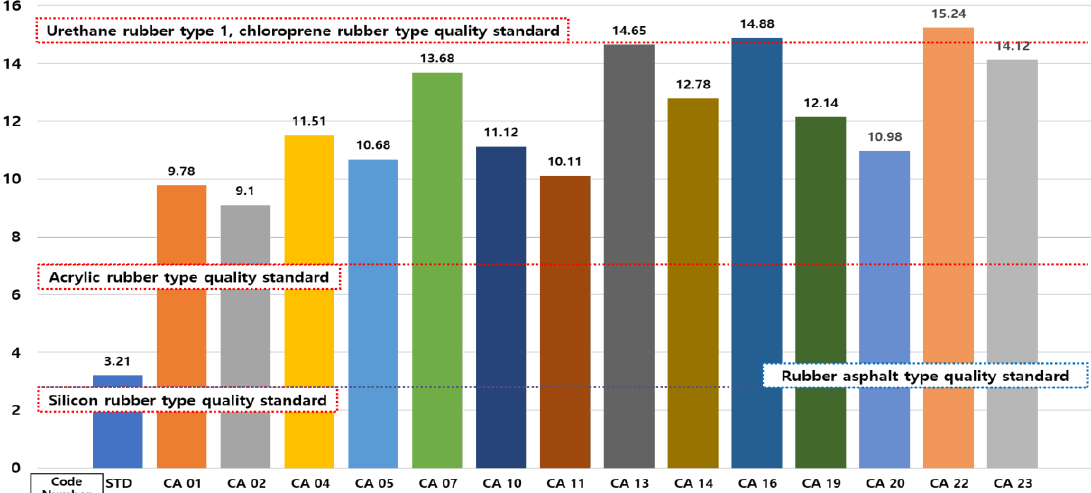
Figure 18. Comparison of composite additive tear strength test results and quality standards. Figure 19. Composite additive solid content test result. Figure 19. Composite additive solid content test